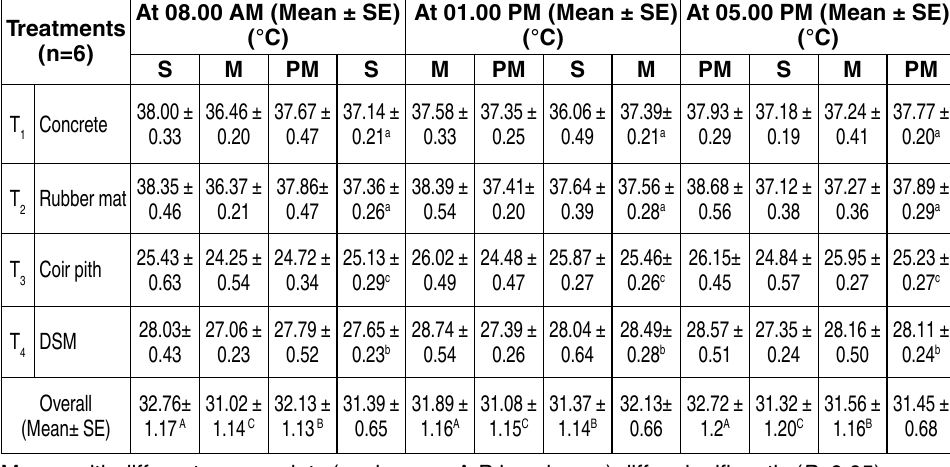
table 1. Mean heat generated from cow body in different bedding systems during different seasons treatments (n=6)